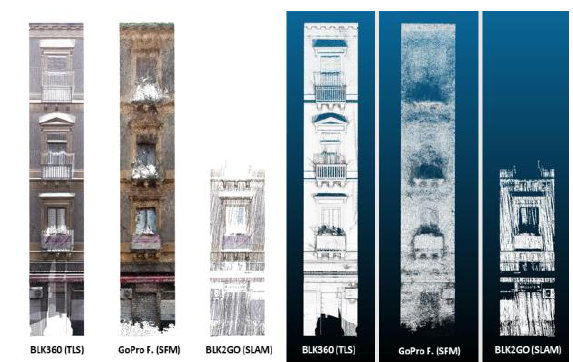
Figure 9 . Density comparison between TLS, SFM and SLAM.